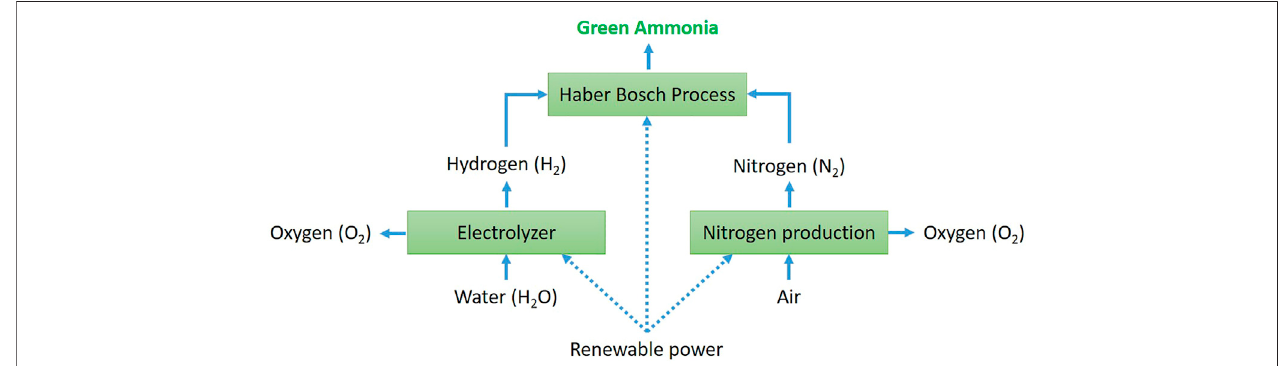
FIGURE 2 | Green ammonia production through electrolysis of water + Haber – Bosch